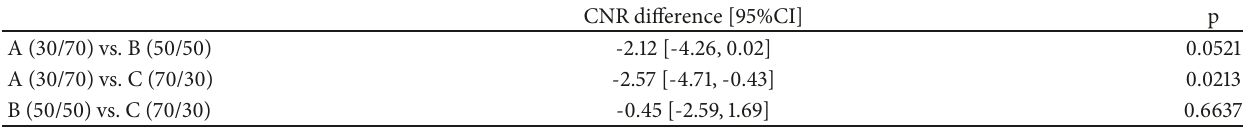
Table 4: Pairwise differences in the CNR between phantoms with different mammary gland ratios.